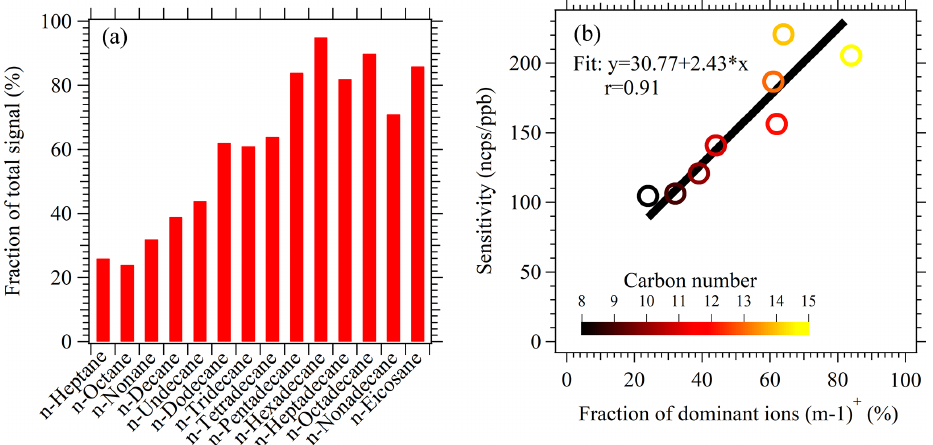
Figure 4. (a) The fractions of product ions ( m − 1) from hydride abstraction of C8–C20 n -alkanes in NO + PTR-ToF-MS. (b) Scatterplot of sensitivities under dry conditions vs. the fractions of hydride abstraction ions for C8–C15 n